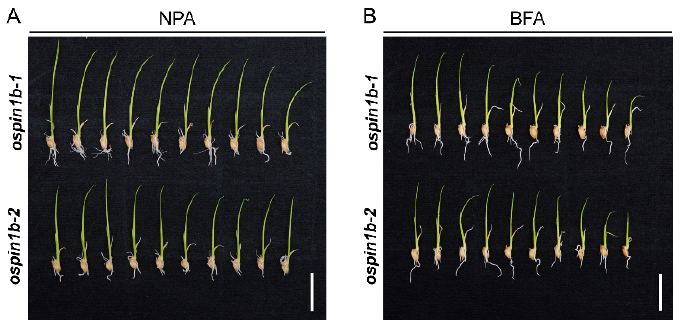
Figure 11. NPA and BFA treatment substantially rescued ospin1b curly root phenotype. ( A ) 0.01 μ M NPA treatment. ( B ) 1 μ M BFA treatment. Bar = 2 cm.